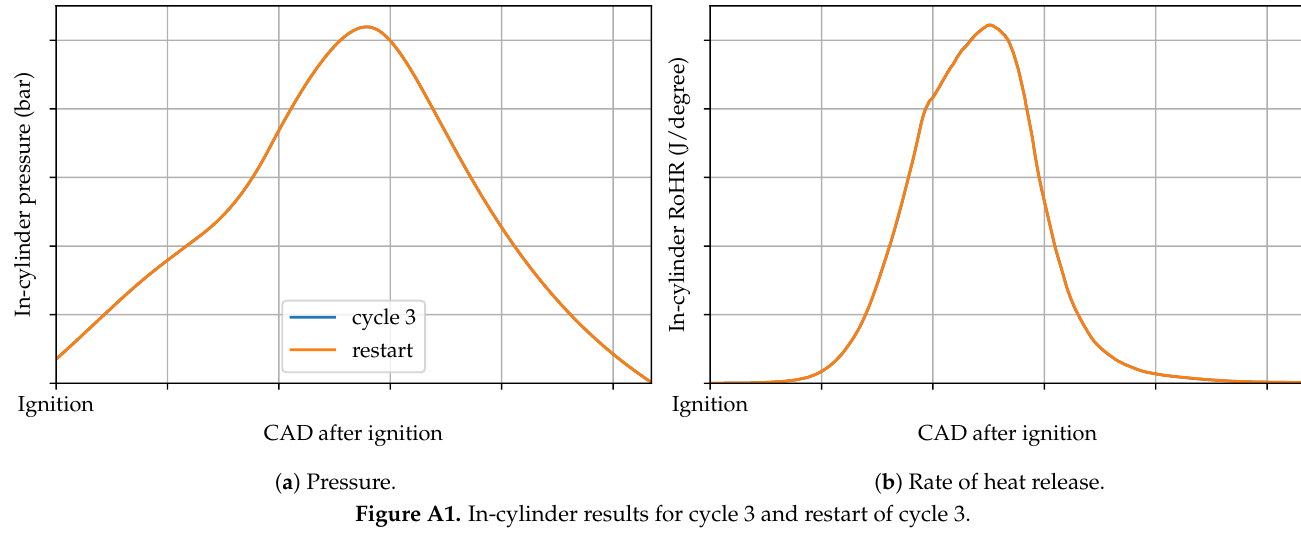
Figure A1. In-cylinder results for cycle 3 and restart of cycle